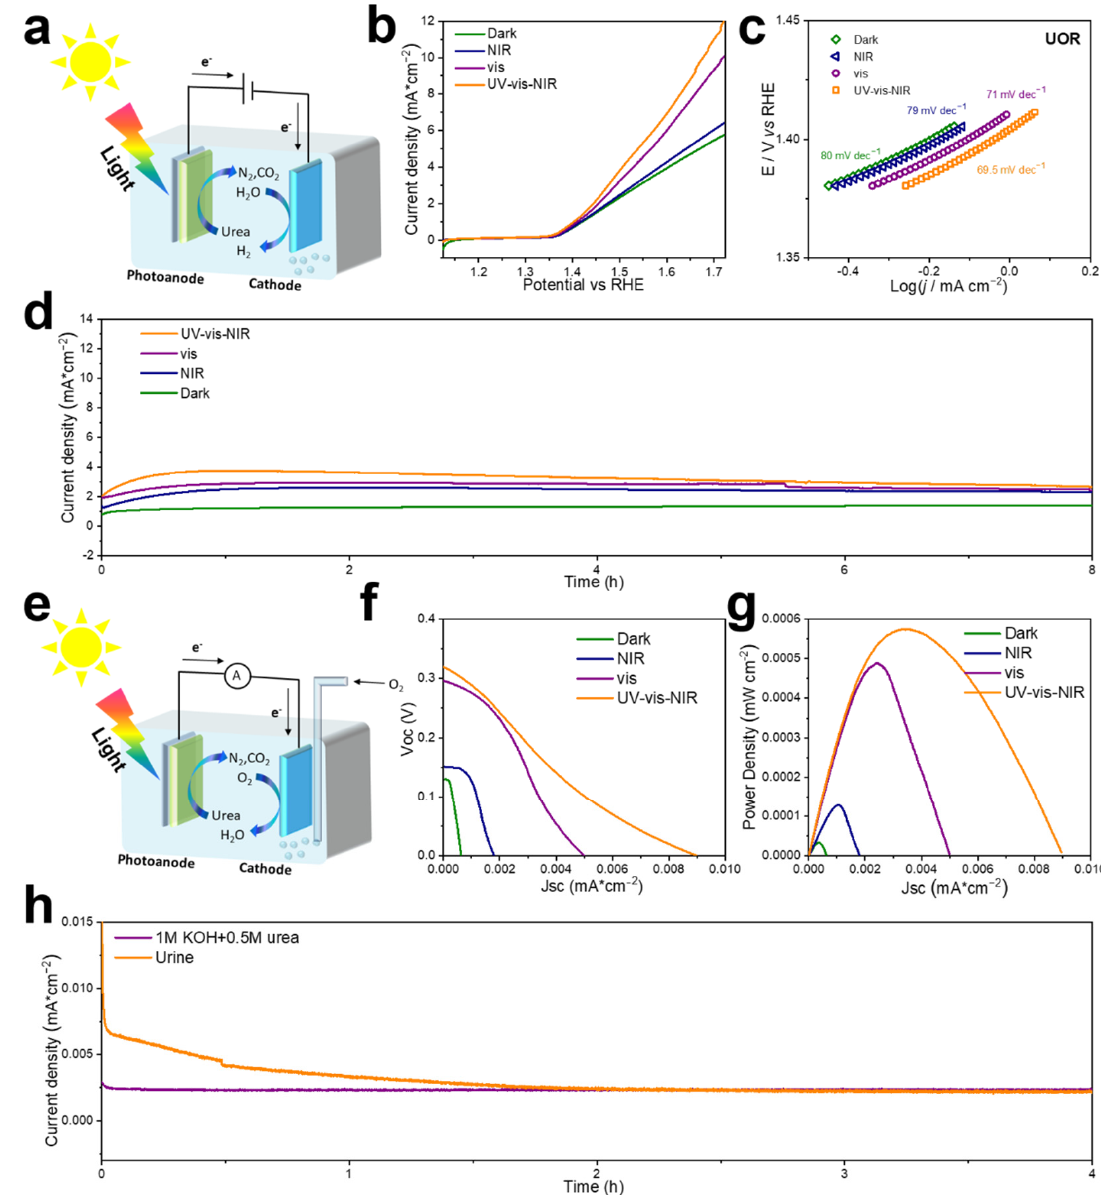
Figure 4. ( a ) Schematic diagram of the energy-saving hydrogen production process assisted by urea photoelectrocatalysis under various light source irradiations. ( b ) Polarization curves for the UOR of various light source irradiations. ( c ) Tafel plots for the UOR derived from ( b ). ( d ) Chronoamperometry responses recorded under various light source irradiations. Photoelectrocatalytic activity tests were performed in N 2 -saturated 1 M KOH with 0.5 M urea electrolyte. ( e ) Illustration of a Photocatalytic Urea Fuel Cell (PUFC), based on La 2 NiO 4 photoanode and Pt counter electrode in O 2 -saturated 1 M KOH with 0.5 M urea solution under various light source irradiations. ( f ) Polarization curves, and ( g ) corresponding power density curves of the PUFC device under different light sources in 1 M KOH with 0.5 M urea solution. ( h ) The current-time plots at 0.1 V output voltages in urea and human urine under NIR light irradiation. The catalyst loading is 1 mg cm − 2 for the DUFC performance